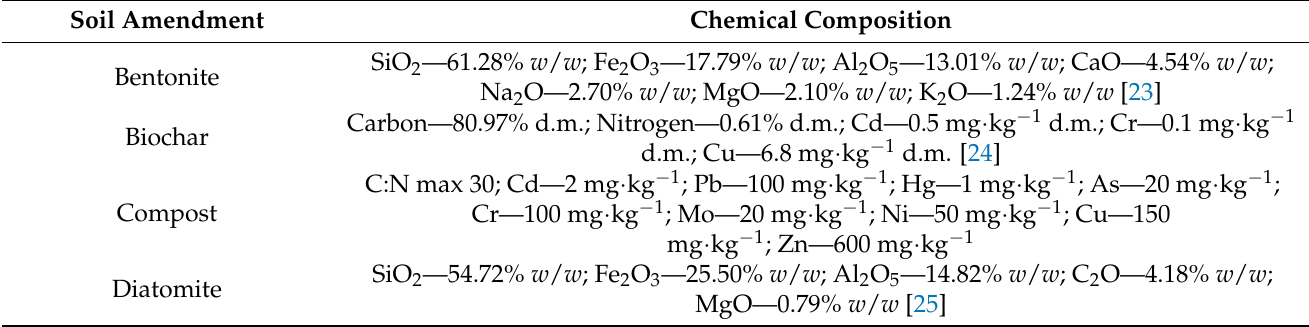
Table 3. Characterization of soil